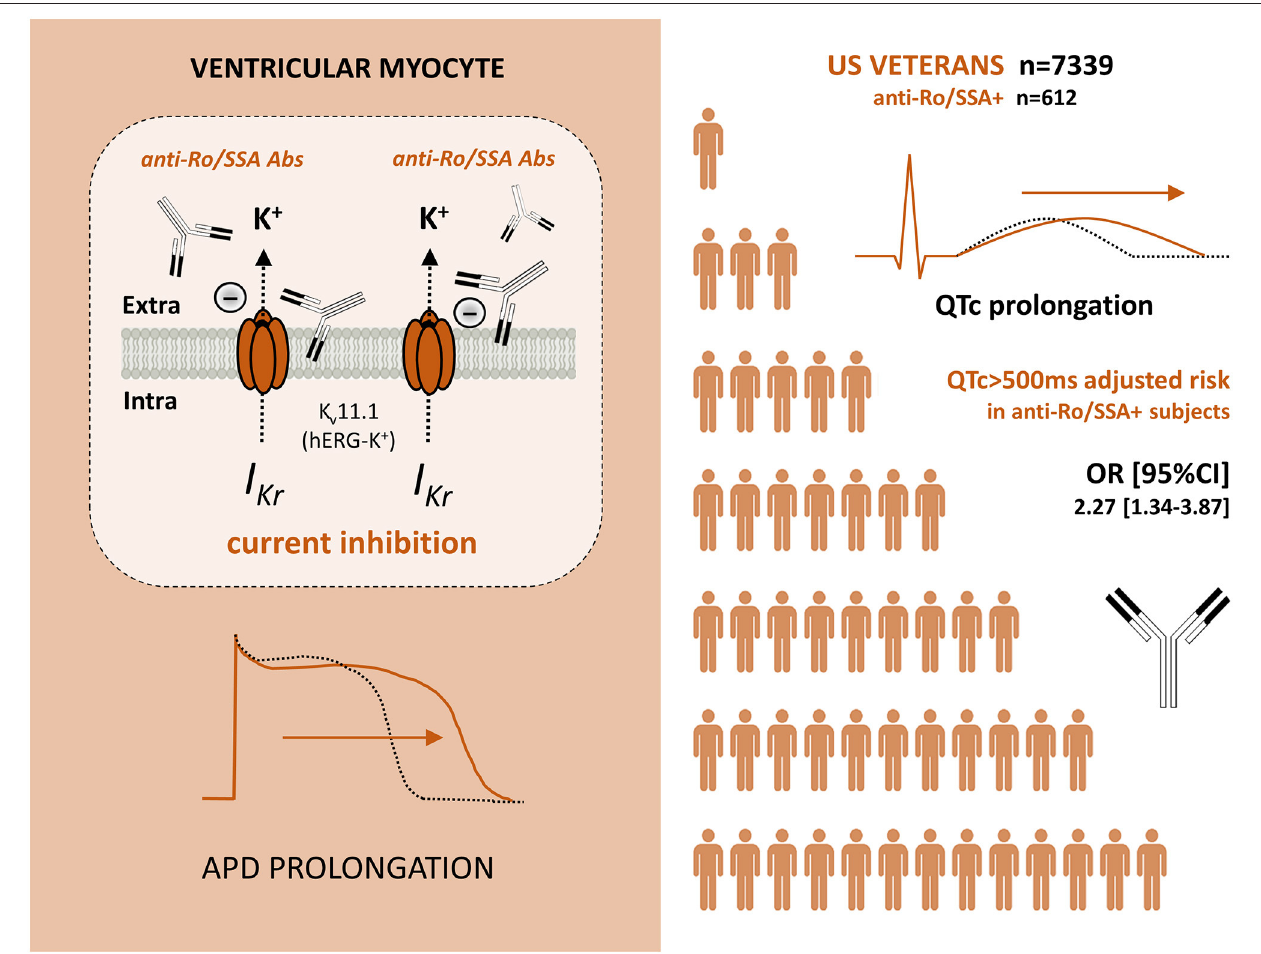
FIGURE 1 | Anti-Ro/SSA antibodies, which can inhibit the I Kr current by directly recognizing hERG potassium channel (brownish), are independently associated with an increased risk of marked QTc prolongation in a large cohort of Veterans (white). Abs, Antibodies; I Kr , rapidly activating component of the delayed outward-rectifying K + current; hERG-K + , human ether-à-go-go related gene potassium channel; APD, Action potential duration; QTc, heart rate-corrected QT-interval; OR, odds ratio; CI, confidence